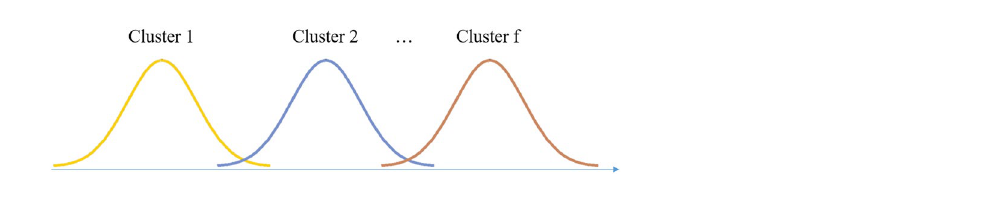
Figure 6. Distribution of experts in